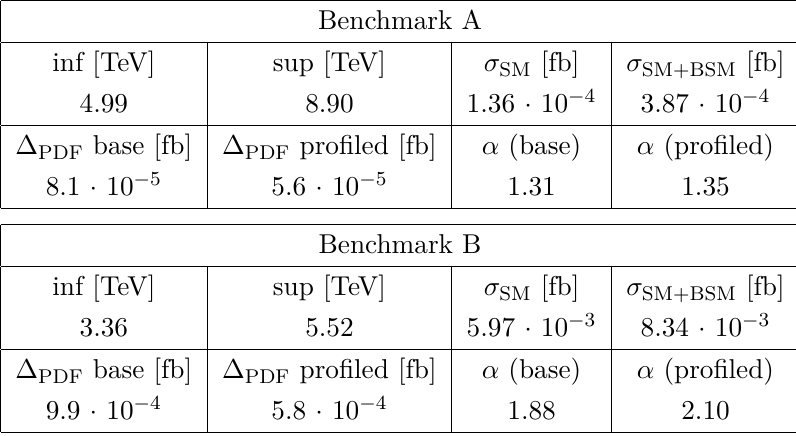
Table 2 . Integration limits for the peak region, integrated cross section for the SM background and the complete model and its PDF uncertainty with the baseline CT18NNLO PDF set [37] and the profiled PDF set using A FB + A W pseudodata as well as the significances α employing the two PDF errors for an integrated luminosity of 3000 fb − 1 for the benchmarks A and